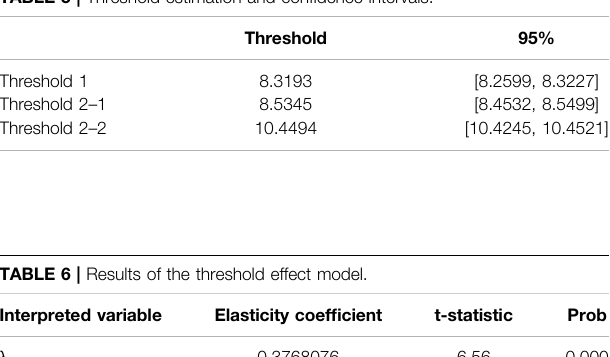
TABLE 5 | Threshold estimation and con fi dence intervals.